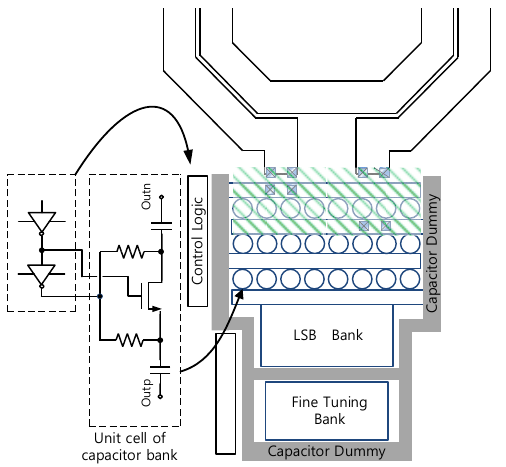
Figure 5. Layout for high isolation between the unit capacitor cell and the control circuit.